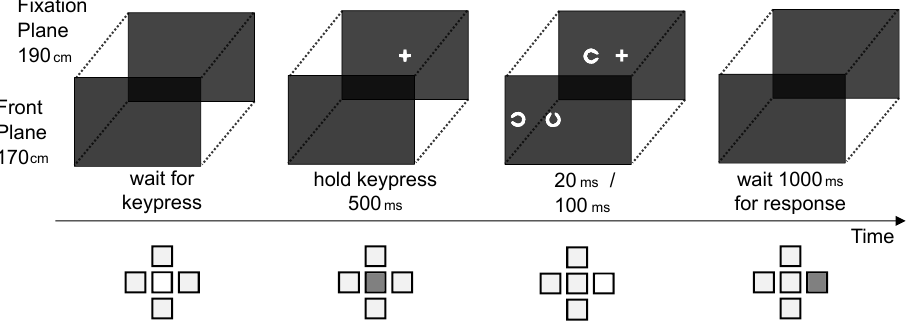
Figure 2. Exemplary sequence of one trial (top) with defocused flankers and response pattern (bottom). A trial was started by pressing the central key. The fixation cross was presented on the fixation plane. After 500 ms of key press, stimuli were presented (for 20 ms in Experiments 1, 2, 4, 5, and for 100 ms in Experiments 2 and 5). Either the target stimulus was presented on the fixation